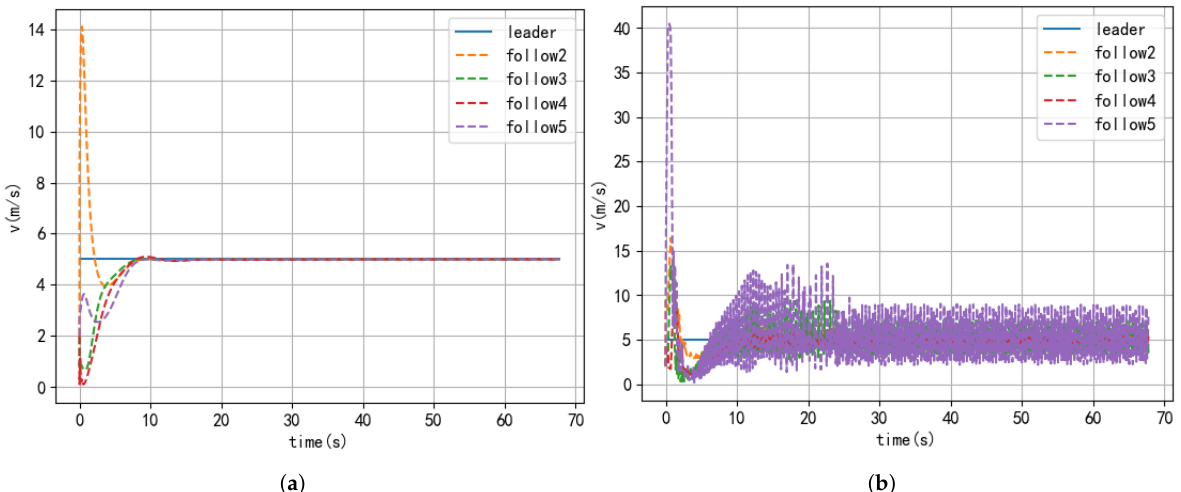
Figure 6. ( a ) Velocity in x-y direction (HEAUVs with event-triggered); ( b ) velocity in x-y direction (HEAUVs with